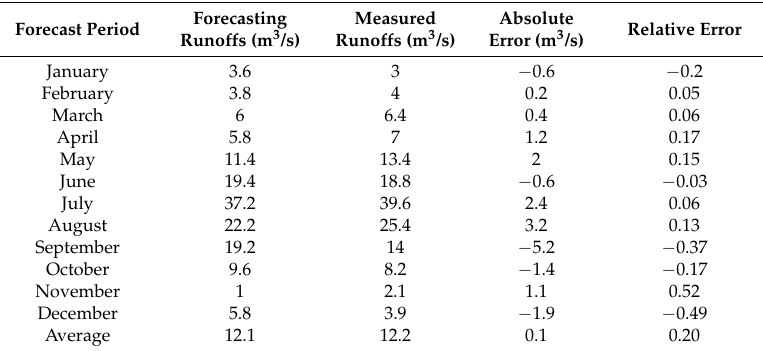
Table 1. Statistical analysis table of forecasted runoff results in 2003.